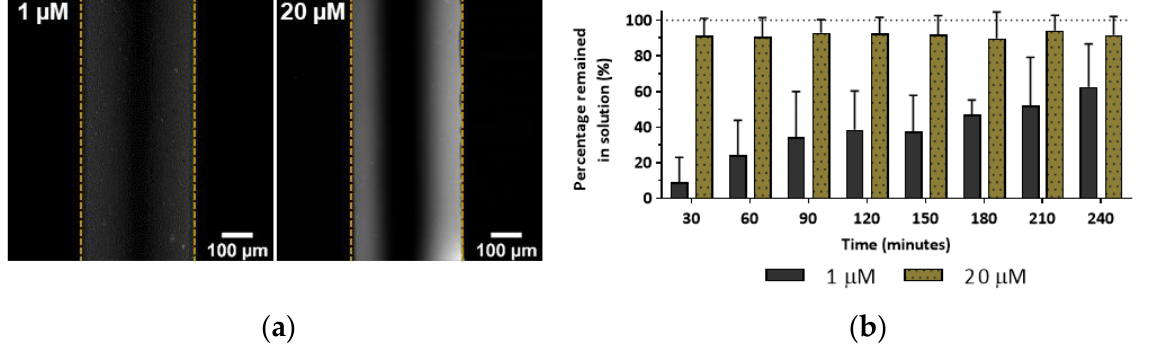
Figure 3. ( a ) Confocal microscopy images of PDMS channel walls following continuous flow of 1 µM or 20 µM rhodamine B solutions. ( b ) Relative concentration ratio over time (expressed as a per- centage) of rhodamine B that remained in solution following continuous flow through the PDMS microchannels 400 µL∙h −1 . Values show Mean ± SD from at least three independent measurements.